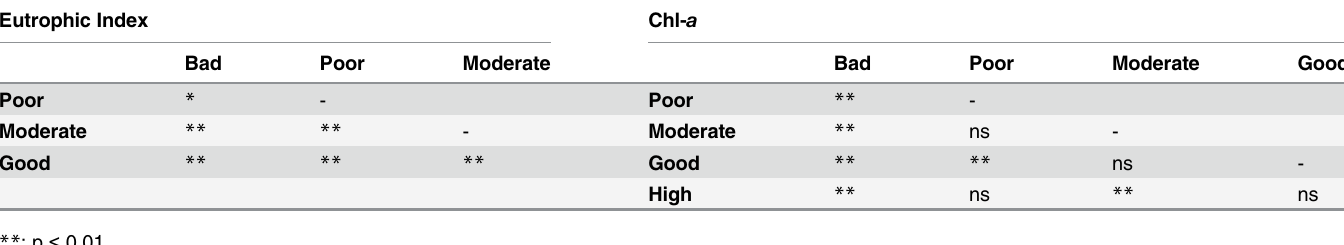
Table 3. Results of ANOSIM test of the benthic community data. Stations were grouped after the status of the seawater column based on the Eutrophic Index and Chl- a . Eutrophic Index Chl-